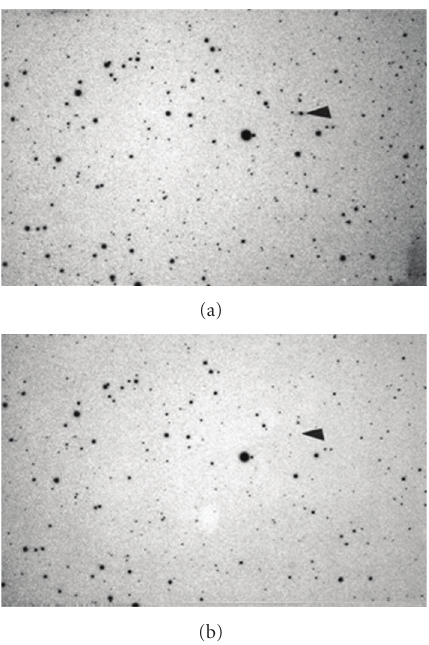
Figure 6: The OT Triangulum. Above the discovery plate with the OT (estimated magnitude B ∼ 10 . 5) indicated, below a comparison plate with no object at the position. Astrograph plate from the Sonneberg Observatory archive, limiting magnitude 17.